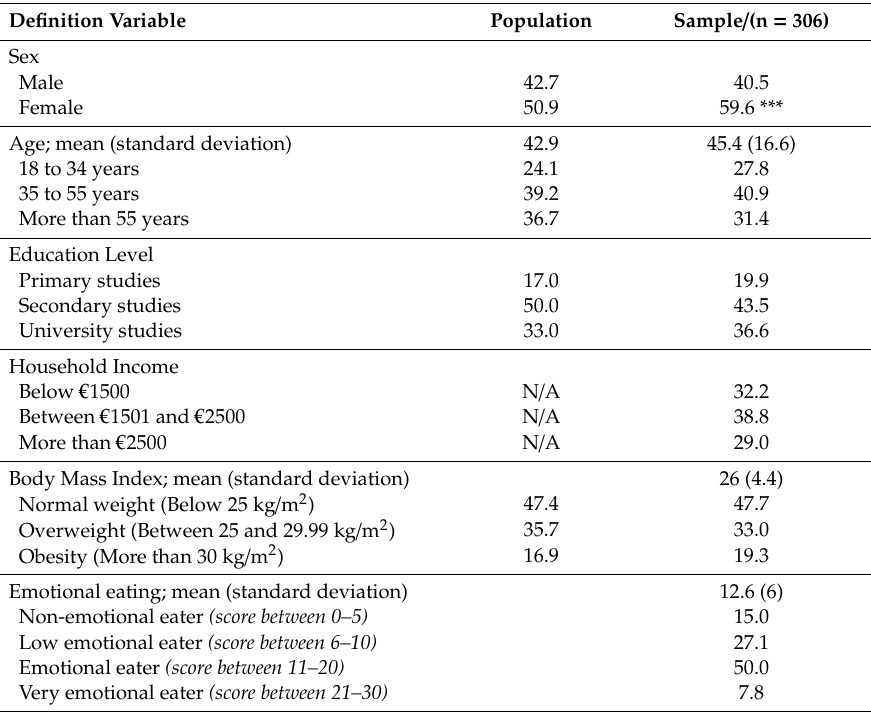
Table 2. Sample sociodemographic